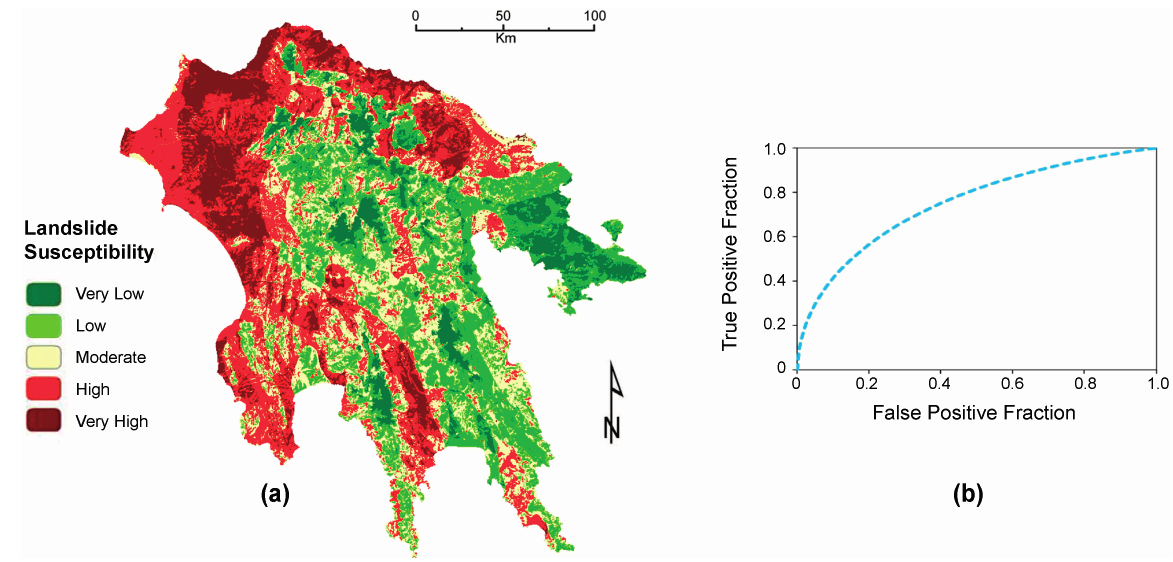
Figure 2. ( a ) The landslide susceptibility map produced by the LSI model and ( b ) receiver operating characteristics (ROC) curve for the LSI